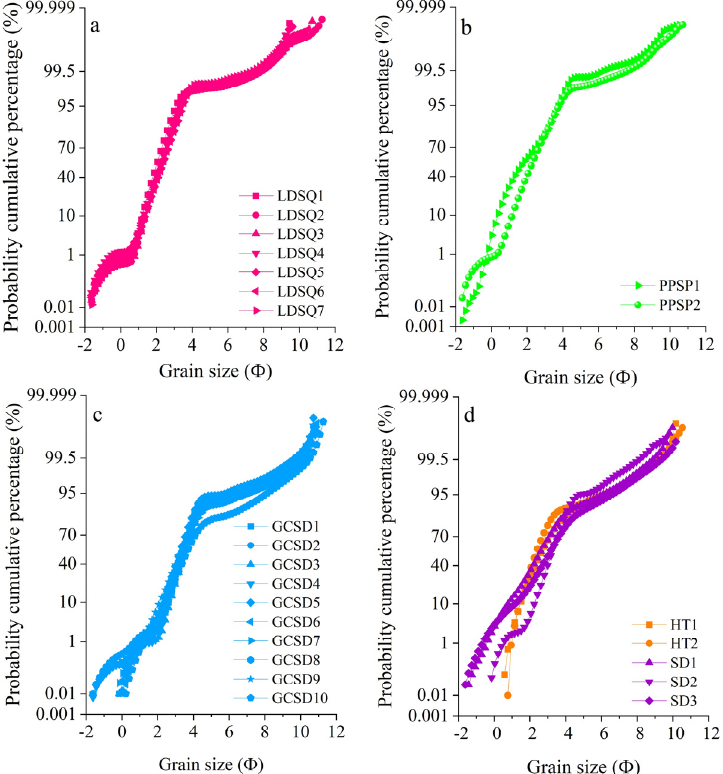
Figure 6. Grain size probability curves in mobile dunes ( a ), climbing sand sheets ( b ), nebkhas ( c ), and flood plain and lakeshore ( d ).